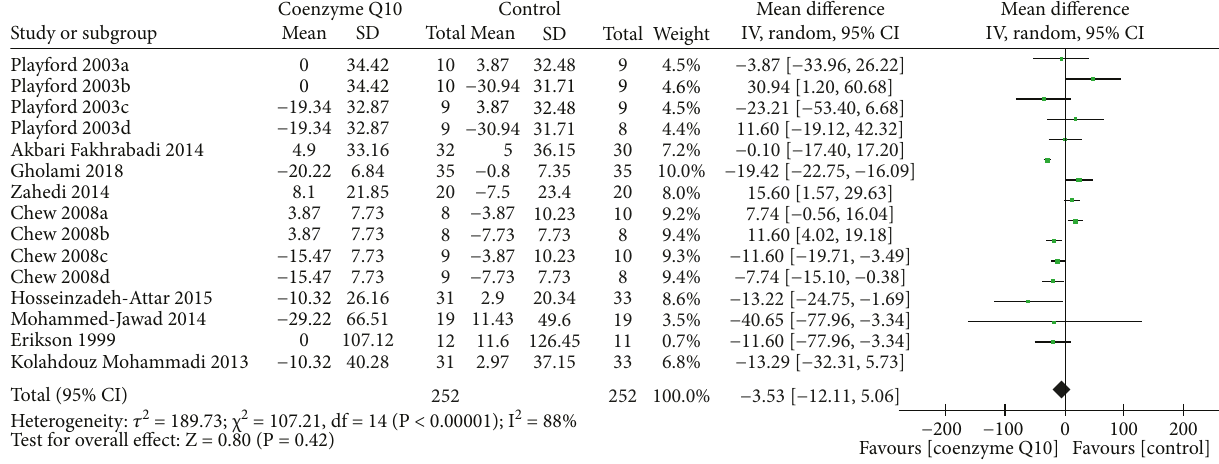
Figure 7: Total cholesterol.